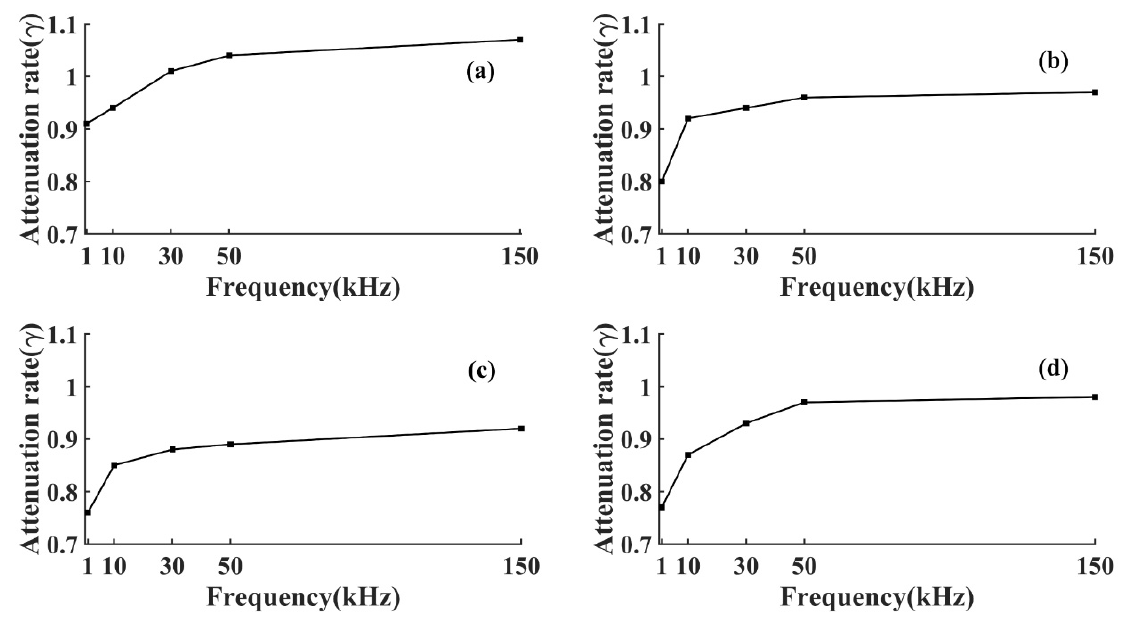
Figure 5. Amplitude attenuation coefficient γ . ( a ) T1 specimen; ( b ) T2 specimen; ( c ) T3 specimen; ( d ) T4 specimen.